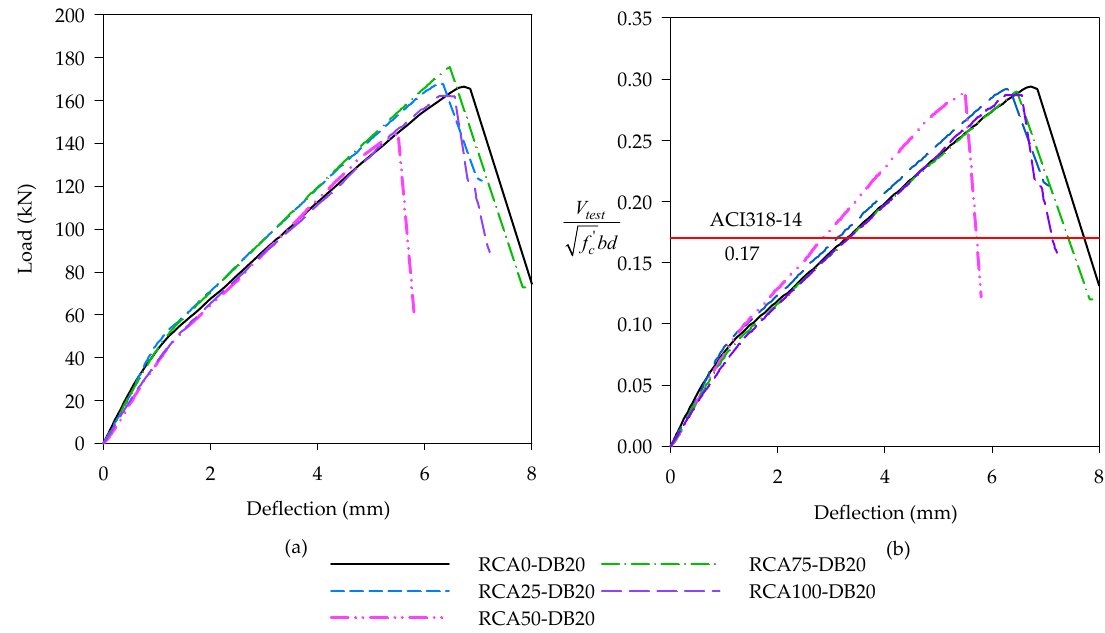
Figure 5. ( a ) Load-deflection curve for beams with reinforcement ratio, ρ w = 1.81%, and ( b ) Normalized shear stress vs. deflection for beams with longitudinal reinforcement ratio, ρ w = 1.81%.